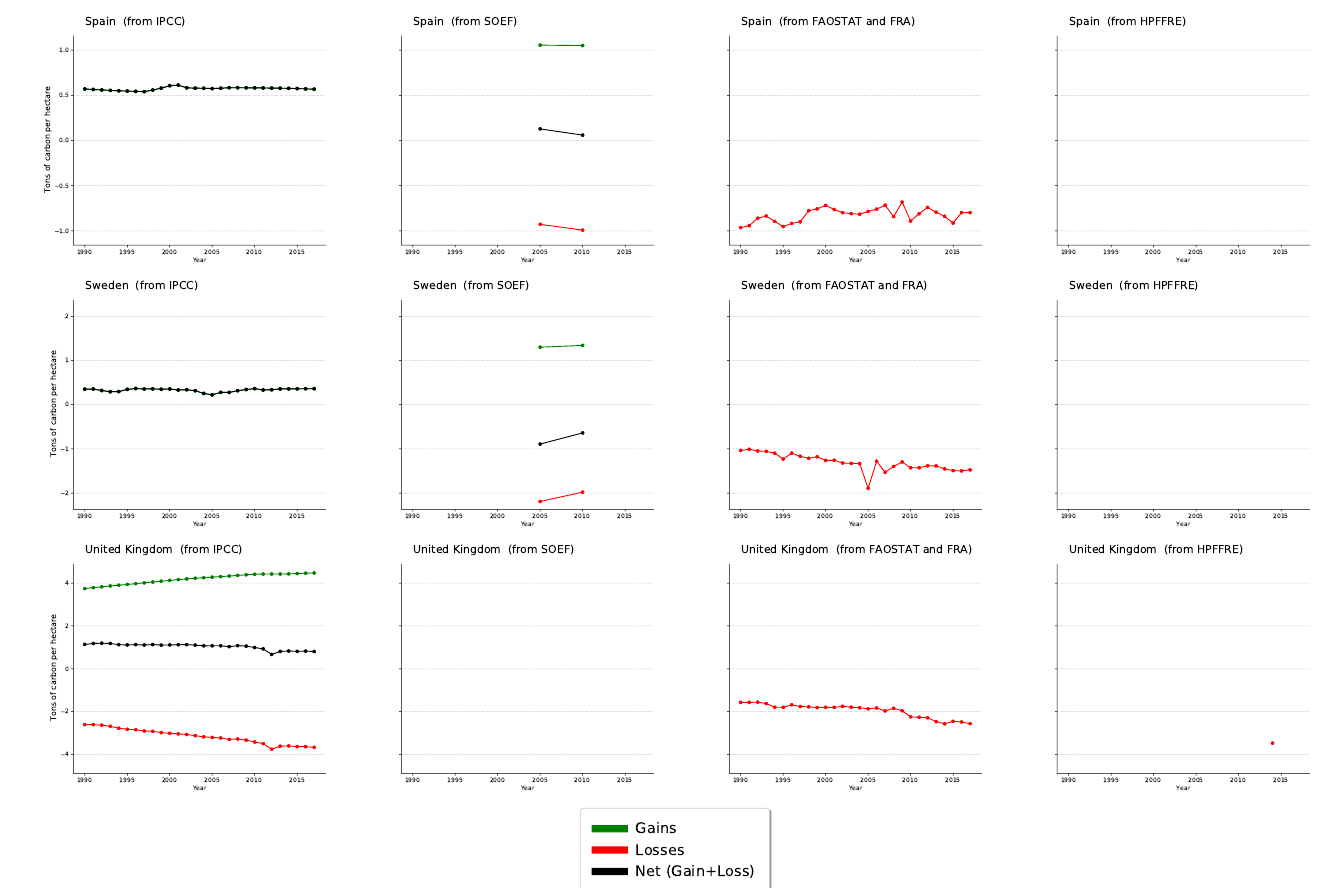
Figure A2. Comparison of the forest dynamics expressed in tonnes of carbon for all countries.